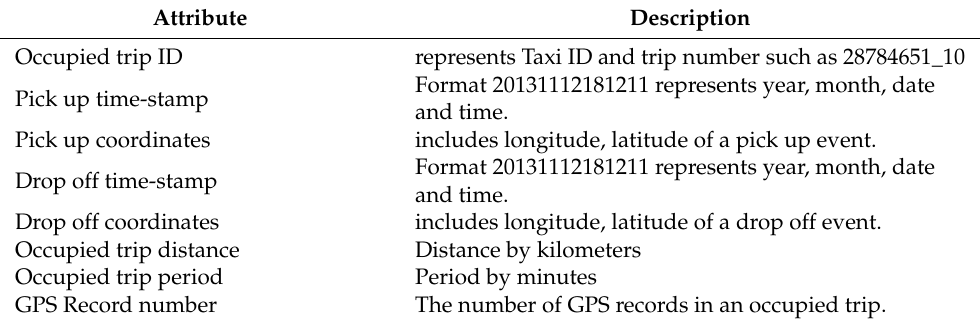
Table 3. Attributes of an occupied